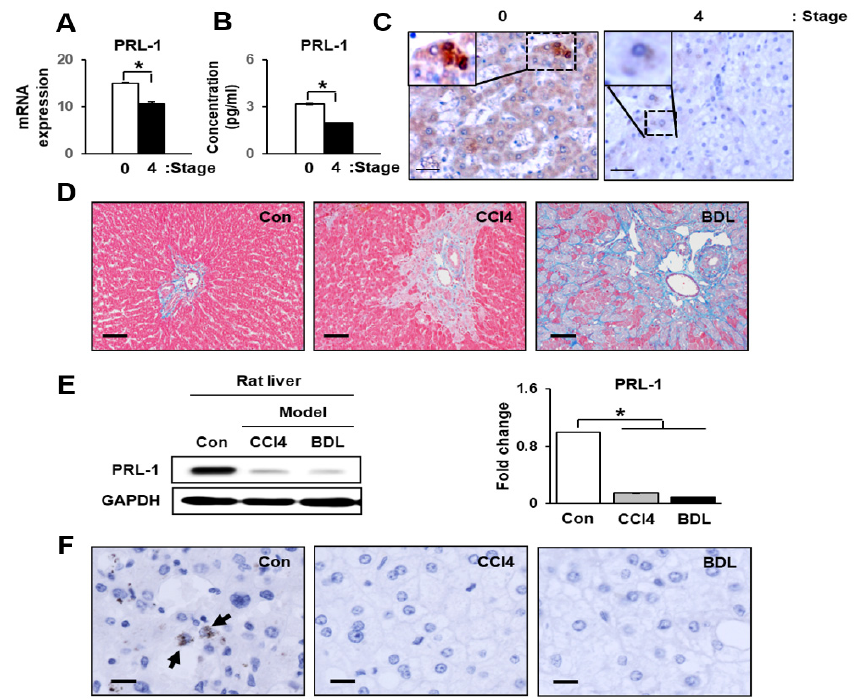
Figure 1. PRL ‐ 1 correlates with liver injury in a human and animal disease model. ( A ) The relative expression and ( B ) concentration of PRL ‐ 1 in fibrotic human liver (e.g., stages 4) compared with stage 0 human liver by quantitative RT ‐ PCR and ELISA, respectively. ( C ) Localization and expression of PRL ‐ 1 were detected in non ‐ fibrotic human liver ( n = 5; stage 0) and severe cirrhosis ( n = 5; stage 4). Liver sections were stained using anti ‐ PRL ‐ 1. PRL ‐ 1 ‐ positive signals (DAB chromogen in brown) were detected in the cytoplasm and nucleus of hepatocytes in stage 0 human liver. The scale bar represents 75 μ m. ( D ) The degree of liver fibrosis was analyzed by Masson’s trichrome staining (200×). PRL ‐ 1 expression was evaluated by quantitative ( E ) immunoblotting and ( F ) immunohistochemistry. GAPDH was used as an internal control. Liver sections were stained using anti ‐ PRL ‐ 1. A hematoxylin counterstain was used. The scale bar represents 75 μ m. Filled arrows indicate the PRL ‐ 1 ‐ positive hepatocytes in rat liver tissue. Each experiment was repeated three times. The data are expressed as the mean ± SEM (* p < 0.05).